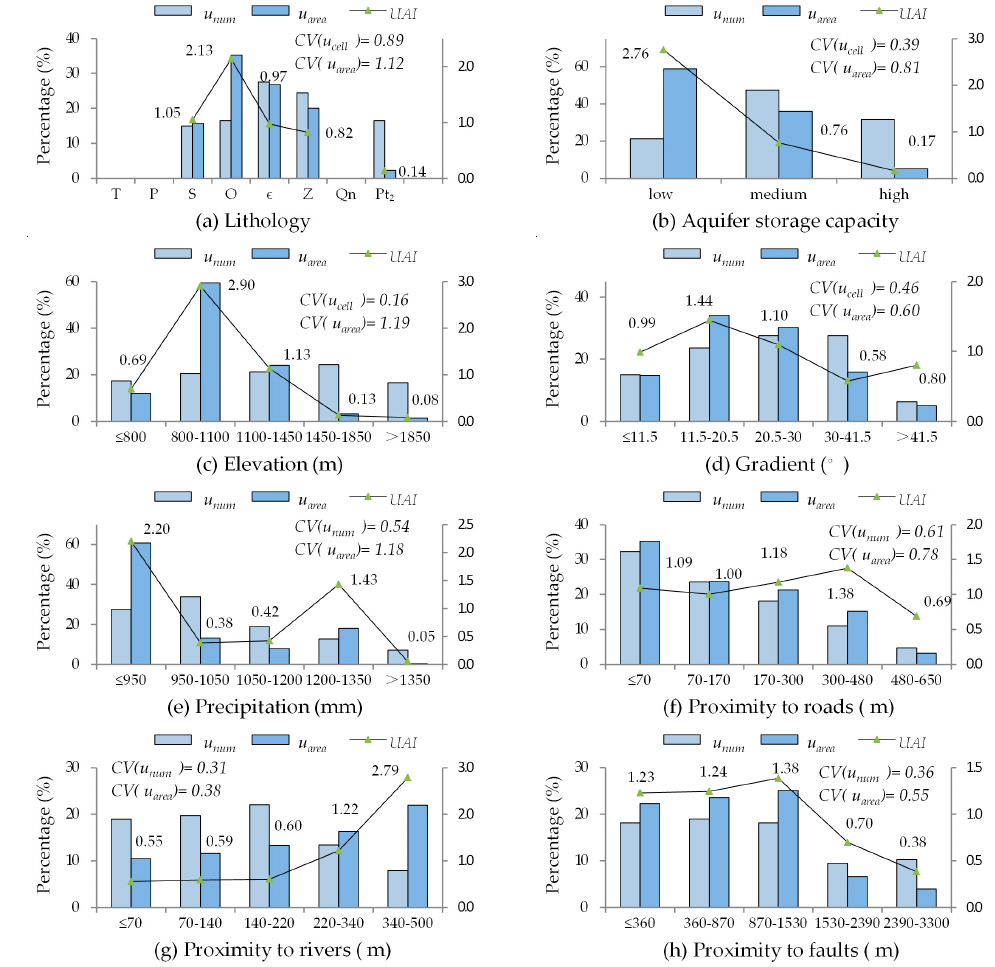
Figure 5. u num and u area of each influence factor: ( a ) lithology; ( b ) aquifer storage capacity; ( c ) elevation; ( d ) gradient; ( e ) precipitation; ( f ) proximity to roads; ( g ) proximity to rivers; and ( h ) proximity to faults. CV is the coefficient of variation; UAI is the unit area index.